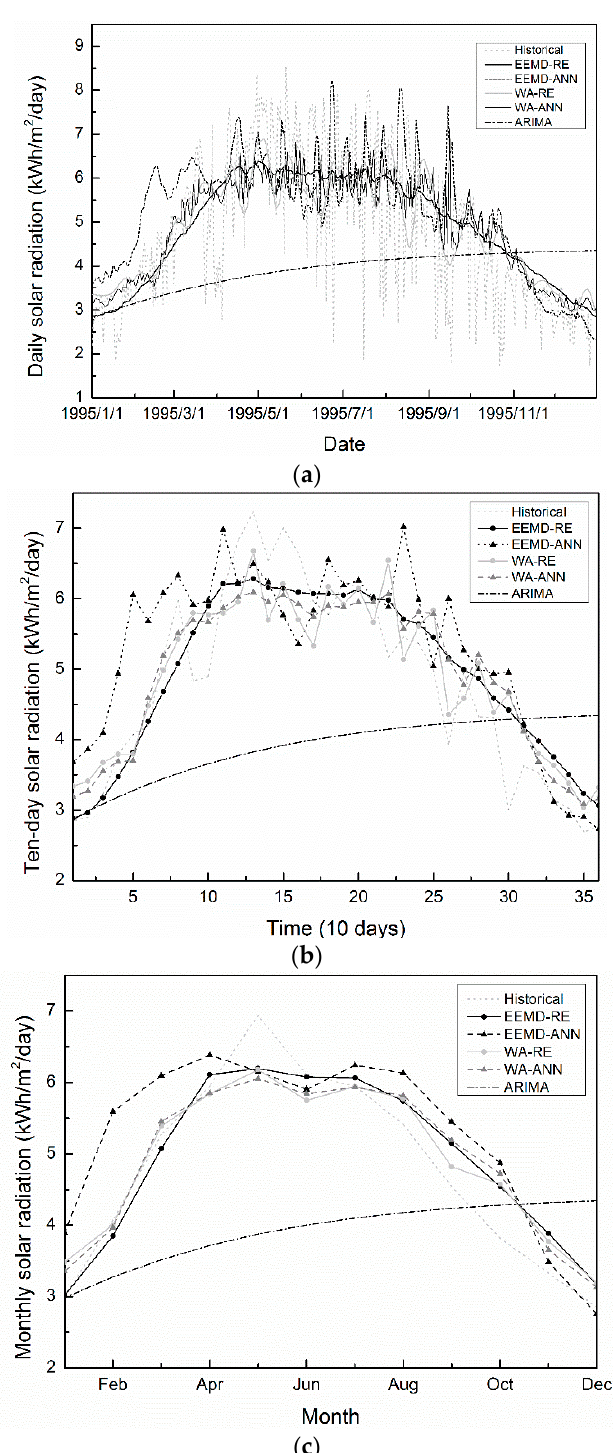
Figure 4. ( a ) Daily prediction results of the year 1995, and its statistcal results with a time step of ( b ) 10 days and ( c ) 1 month. ( b ) 10 days and ( c ) 1